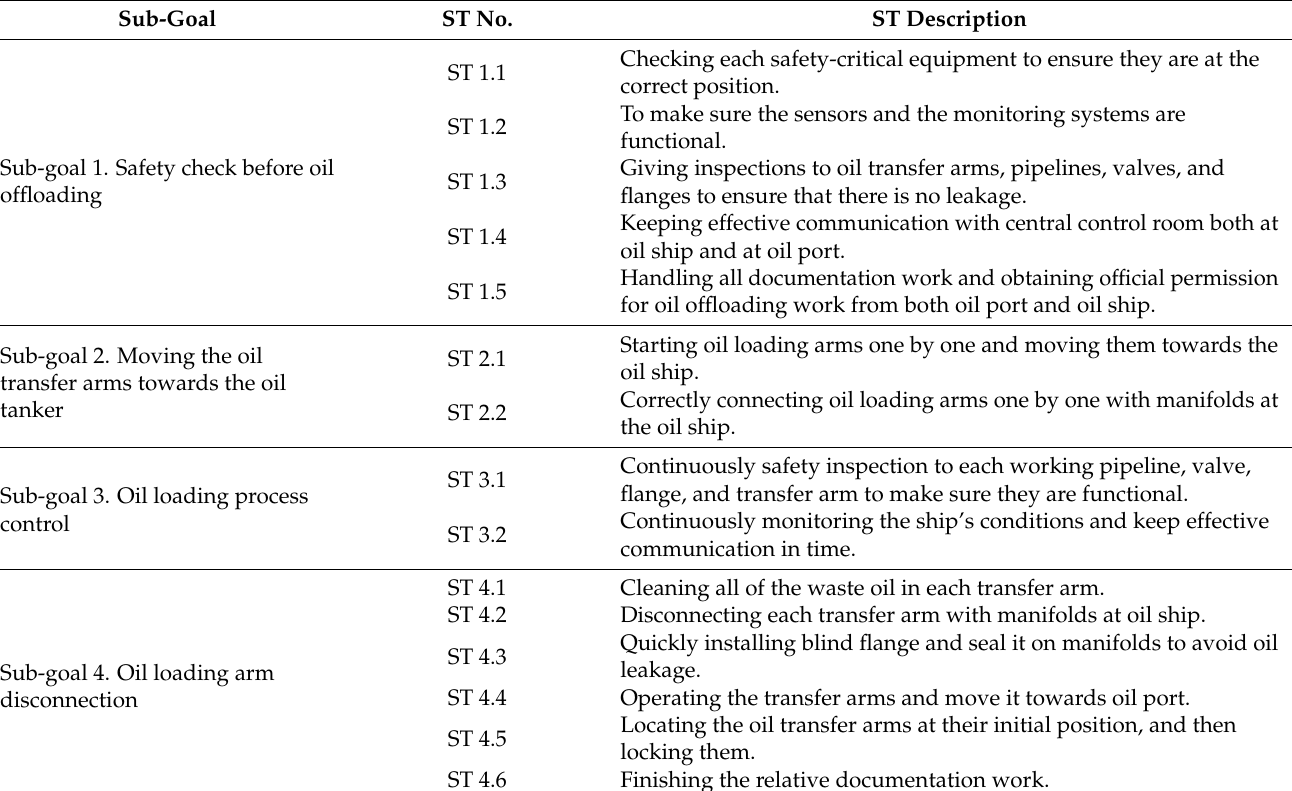
Table 4. The HTA result of the selected oil ship offloading task [6,38].